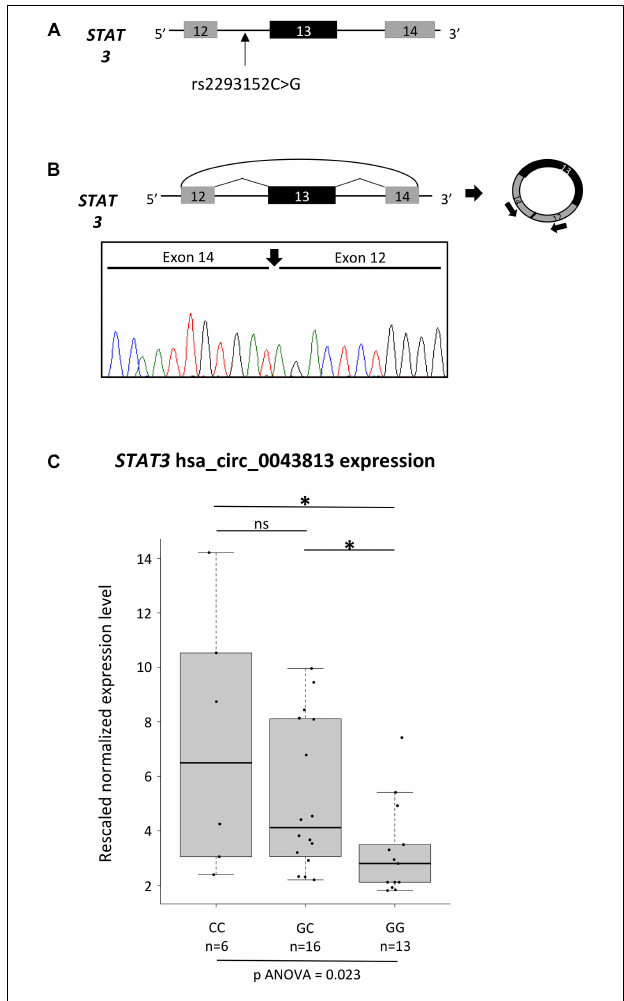
FIGURE 1 | Characterization of the hsa_circ_0043813 circRNA deriving from the STAT3 gene. (A) Schematic representation of the STAT3 genomic region spanning from exon 12 to 14. Exons are depicted as boxes (in scale), and introns as lines. The position of the SNP rs2293152 is shown by an arrow. (B) Schematic representation of the formation of the STAT3 circRNA hsa_circ_0043813 through a back-splicing event between exons 14 and 12. Exons are approximately drawn to scale; the curved arrow joins the 5 (cid:48) splice site of exon 14 to 3 (cid:48) splice site of exon 12. On the right, a schematic representation of the circRNA is depicted; arrows below exon 12 and 14 indicate the divergent primer couple used to detect the circRNA. Below the scheme, direct-sequencing electropherogram shows the head-to-tail splice junction, indicated by a black arrow, located between exons 14 and 12. (C) Boxplots showing expression levels of the hsa_circ_0043813 circRNA measured by semi-quantitative real-time RT-PCR in PBMCs of 35 healthy controls. Boxes define the interquartile range; the thick line refers to the median. Results were normalized to expression levels of the HMBS housekeeping gene, and for each sample three technical replicates were performed. The number of subjects belonging to each group is also indicated (n). The significance level of t -test analysis is shown. ∗ p < 0.05; ns, not